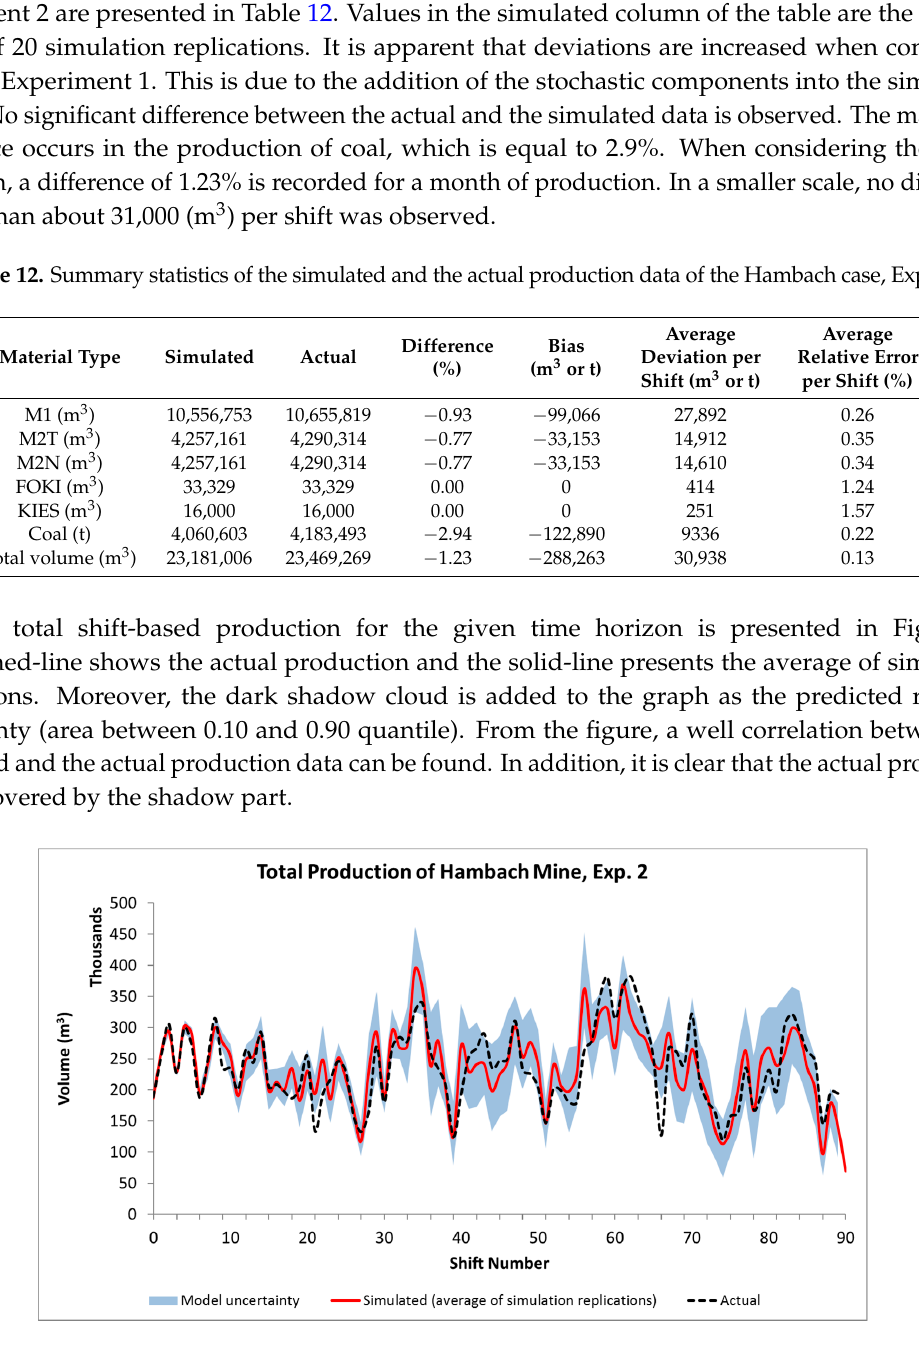
Figure 21. The total shift-based production of the Hambach mine, Experiment 2.